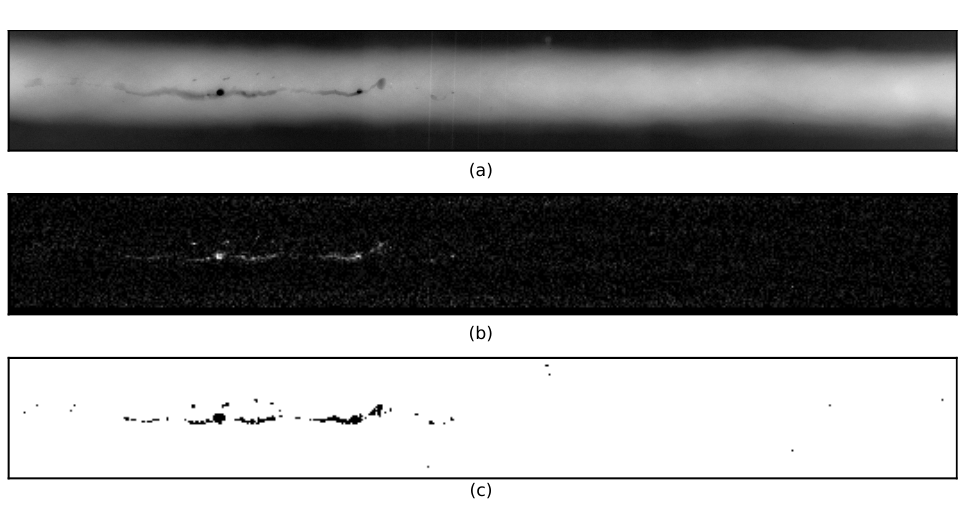
Figure 11. AE model sliding window results for the test dataset. Trained with the SNI perturbation dataset. ( a ) is the original input, ( b ) is the residuals, and ( c ) is the kernel analysis results thresholded with thresholds resulting in an FPR at 0.1% on a patch level.